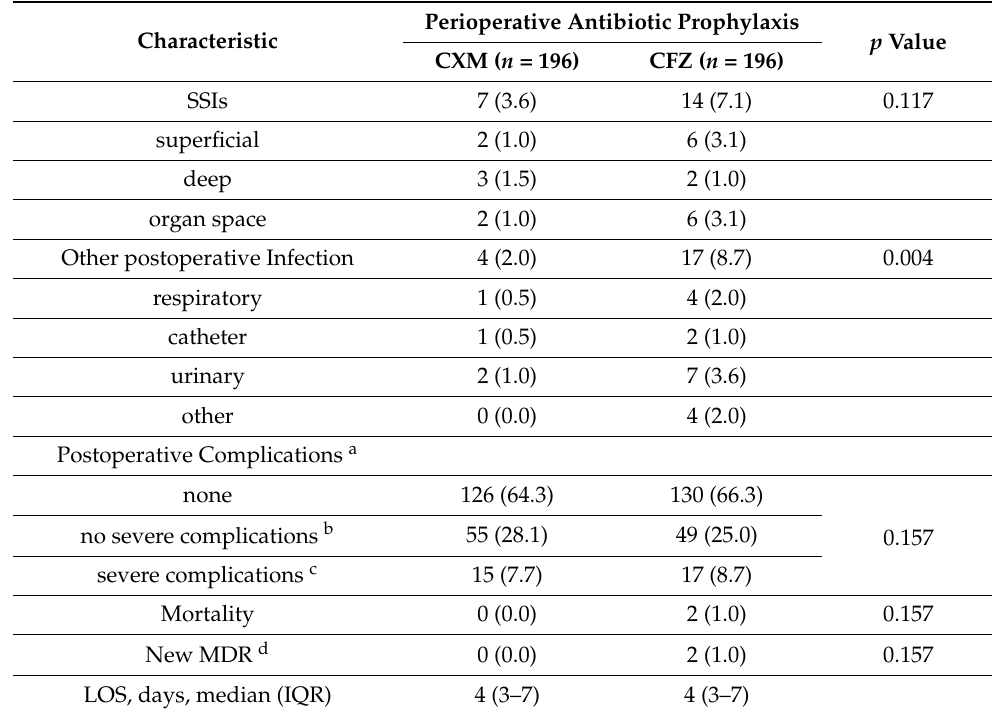
Table 5. Postoperative